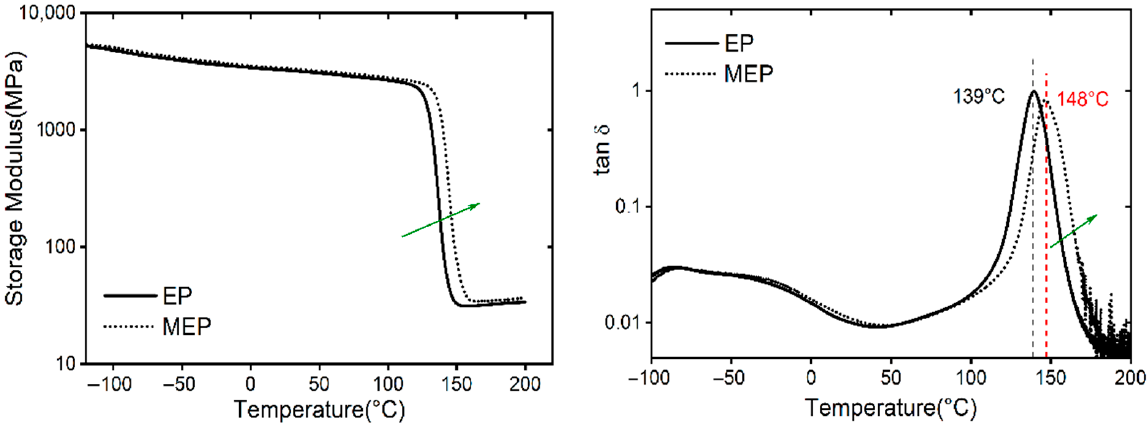
Figure 8. Comparison of the DMA curves for the reference epoxy (EP) and the modified epoxy system (MEP). tan vs. temperature ( right ) and storage modulus vs. temperature ( left ).